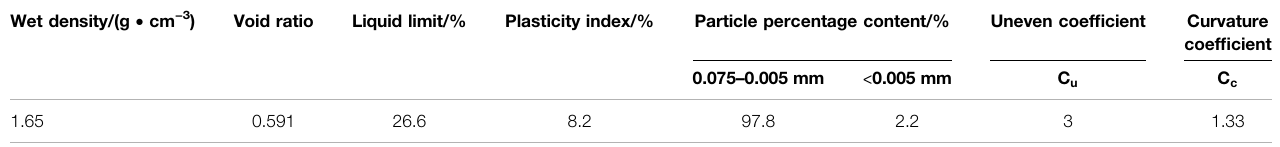
TABLE 1 | Physical characteristics and mechanical properties of silt.